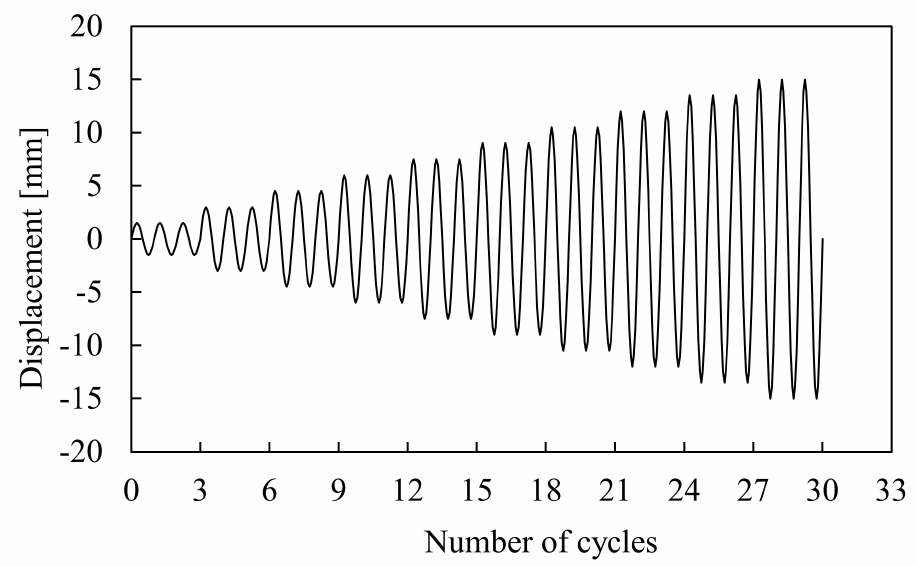
Figure 15. Applied loading scheme on the bolted joint